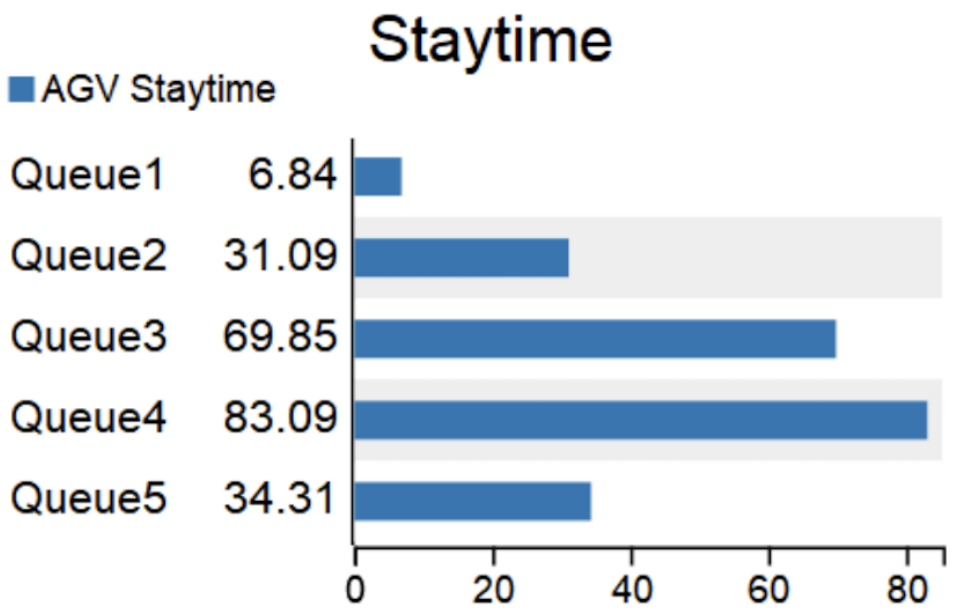
Figure 11. Queuing time of each station